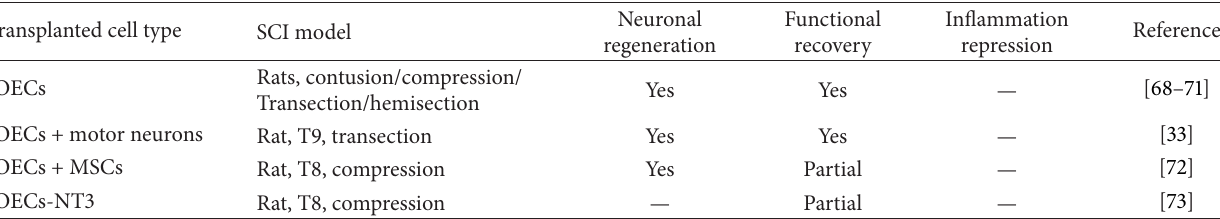
Table 4: Preclinical spinal cord injury trials using olfactory ensheathing cells